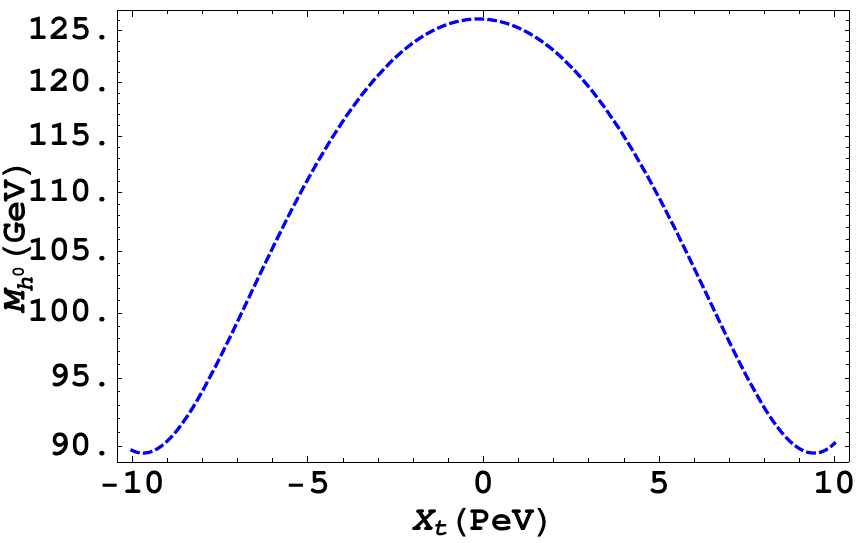
Figure 1 . The (cid:12)gure shows the radiatively corrected light Higgs mass as a function of X t for M A = 9 PeV, M S = 3 : 9 PeV, (cid:22) = 9 : 5 PeV, A b = 1 PeV and tan (cid:12) (cid:24) 50. We can see that for X t = (cid:6) 1 : 1 PeV, we can obtain a light Higgs boson of mass (cid:24) 125 GeV. Thus, by (cid:12)ne-tuning the masses of PeV scale superpartners and other soft SUSY breaking parameters, it is possible to obtain a SM-like light Higgs